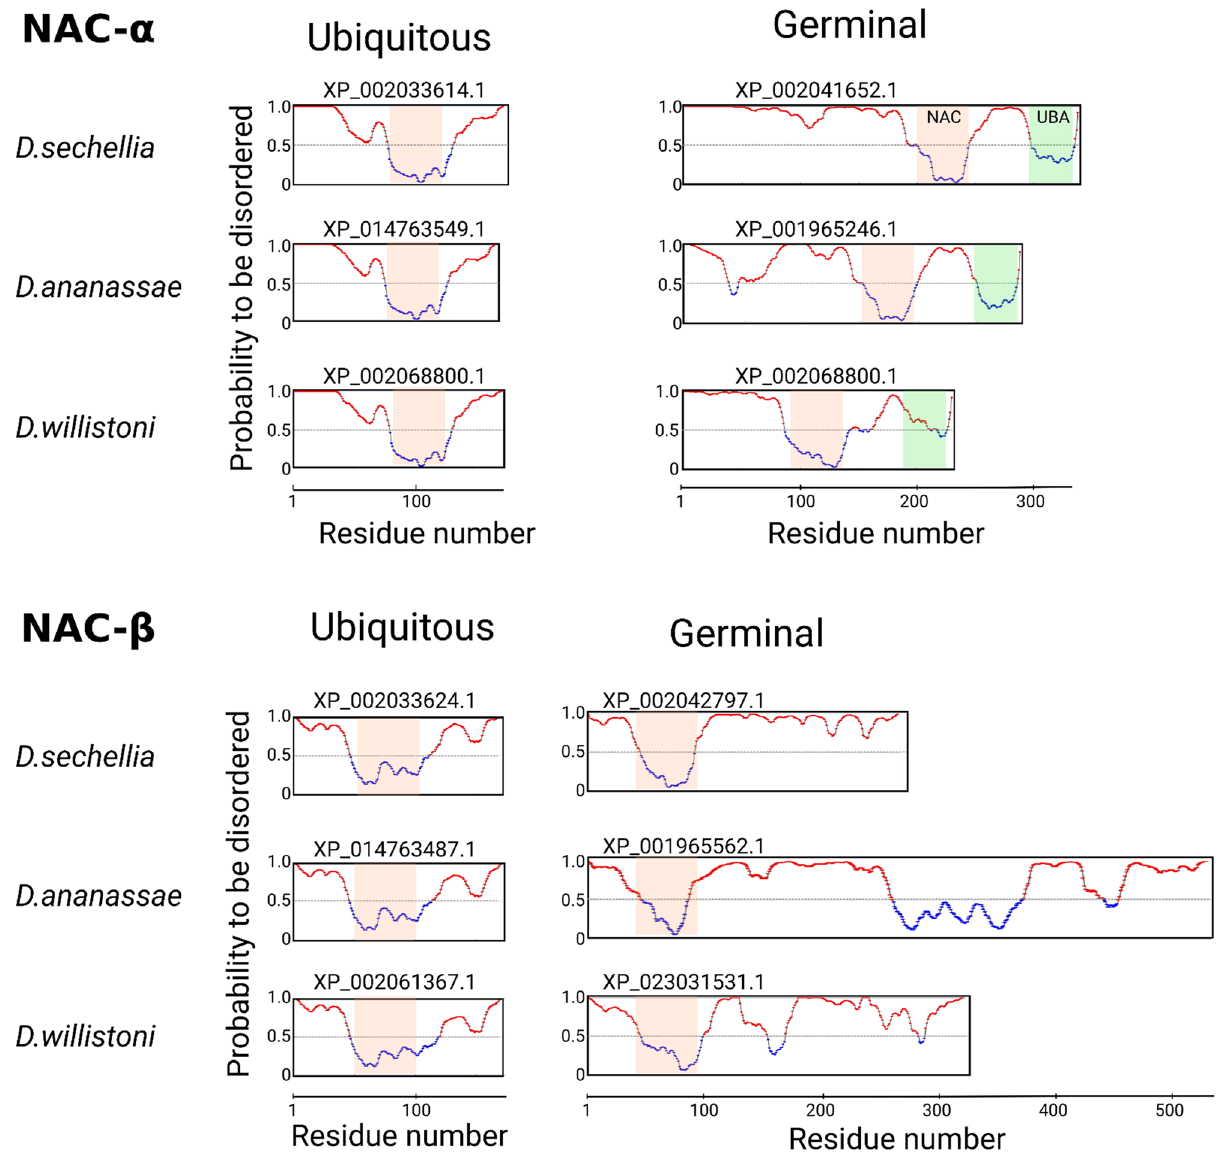
Figure 8. Comparison of order–disorder profiles of ubiquitous and germinal NACα and NACβ orthologs. Disordered and folded regions are marked with red and blue